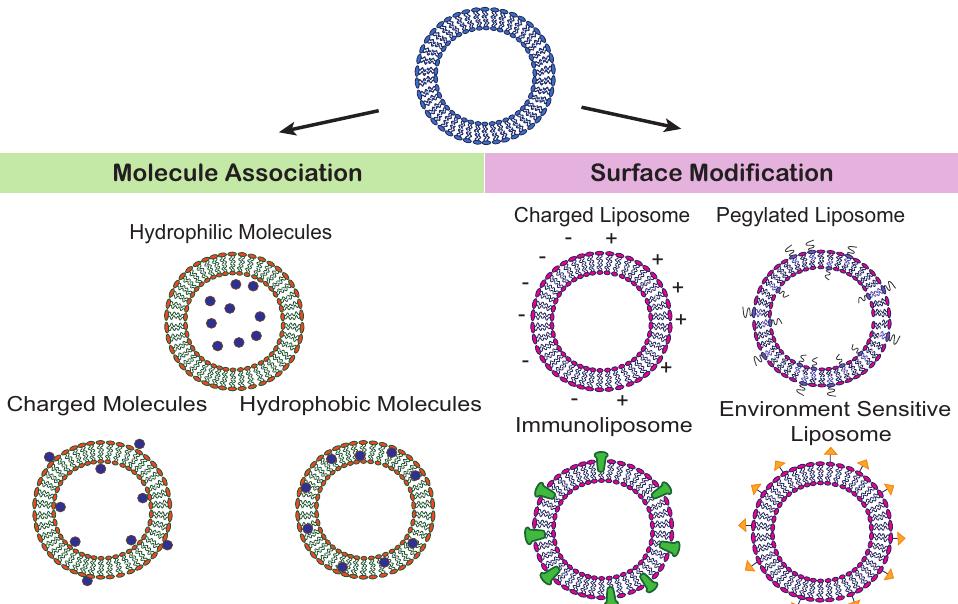
Figure 1. ( Left ) Liposomes can be loaded with molecules of different properties. Hydrophilic molecules are preferably located in the aqueous core, hydrophobic molecules localize within the membrane, and charged molecules may associate with the membrane surface. ( Right ) Surface properties can be tuned by charged lipids, lipids with a bound polymer, e.g., polyethylene glycol (PEG), lipids functionalized with ligands (yellow), and incorporated proteins